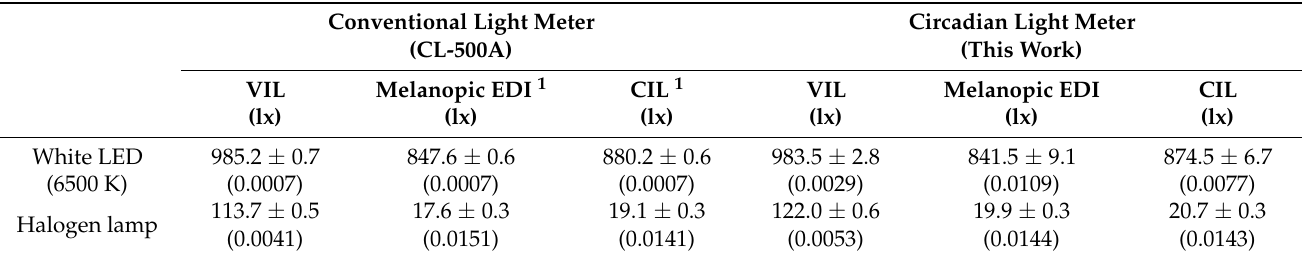
Table 1. Illuminance values according to the lighting sources measured ten times repeatedly under equal conditions. All data represent mean ± standard deviation; values in parentheses represent coefficient of variation.